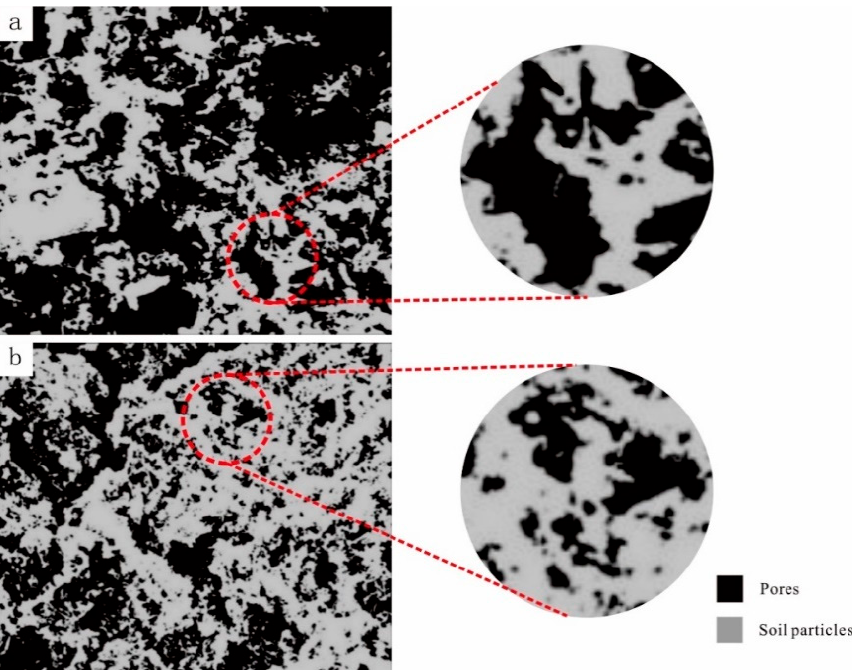
Figure 18. SEM binarization process. ( a , b ) SEM images at 2500 times magnification were selected for qualitative comparison analysis.